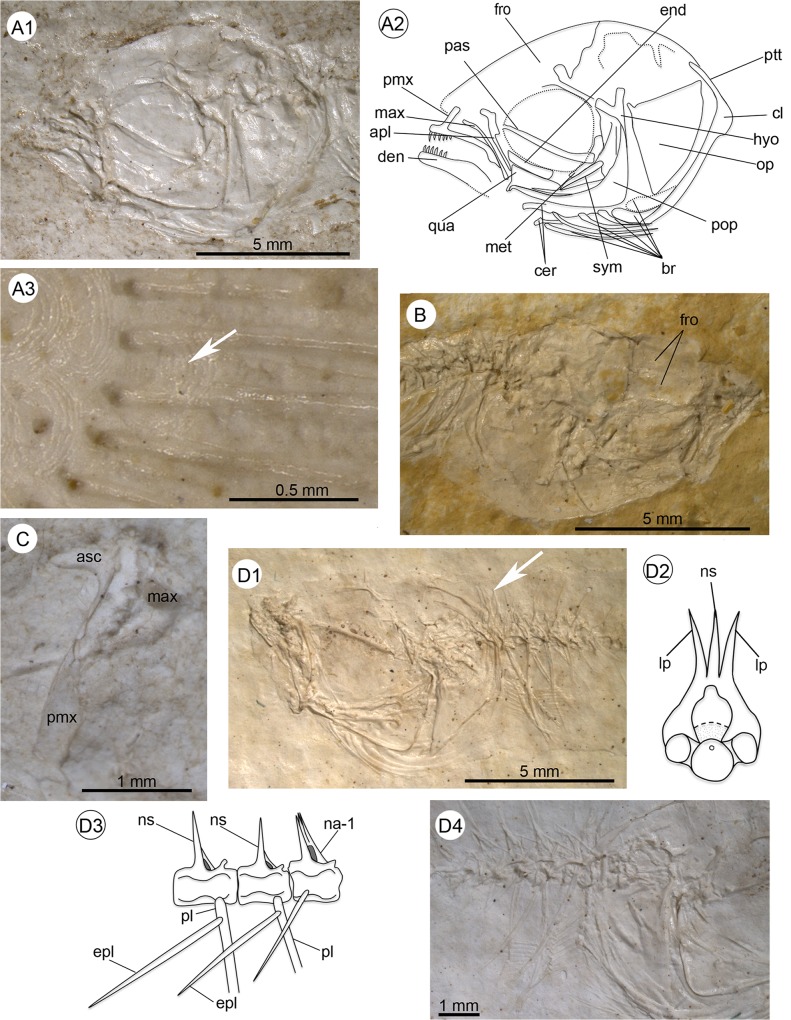
Anatomical details of †Kenyaichthys.
A1–A3 Anatomical details of †
K. kipkechi sp. nov. (paratype 1237R(1)´04): A1–A2 Head and pectoral girdle, left lateral view; A3 Caudal fin rays covered with a single scale (arrow), left lateral view; B Head of †
K. kipkechi sp. nov. (paratype 1160b´04), right dorsolateral view; C Disarticulated premaxilla and maxilla of †
Kenyaichthys cf. kipkechi (1226a(1)´04), right lateral view; D1–D4 Anatomical details of †
K. kipkechi (paratype 1209a/b´05): D1 Head and anterior part of body (1192a´05), arrow indicates lateral processes and spine of the first vertebra, left lateral view; D2 Schematic reconstruction of the first vertebra (paratype 1192a/b´05), anterior view; D3 Reconstruction of vertebrae 1–3 with pleural ribs and rod-shaped epipleural ribs (1192b´05), left lateral view; D4 Head and anterior part of body (1192b´05) with epipleural ribs on vertebrae 1–5, left lateral view. Abbreviations: apl, autopalatinum; br, branchiostegal rays; cer, ceratohyal; cl, cleithrum; den, dentary; end, endopterygoid; epl, epipleural rib; fro, frontal; hyo, hyomandibula; lp, lateral process; max, maxilla; met, metapterygoid; na-1, neural arch of first vertebra; ns, neural spine; op, operculum; pas, parasphenoid; pl, pleural rib; pmx, premaxilla; pop, preoperculum; ptt, posttemporal; qua, quadratum; sym, symplectic.